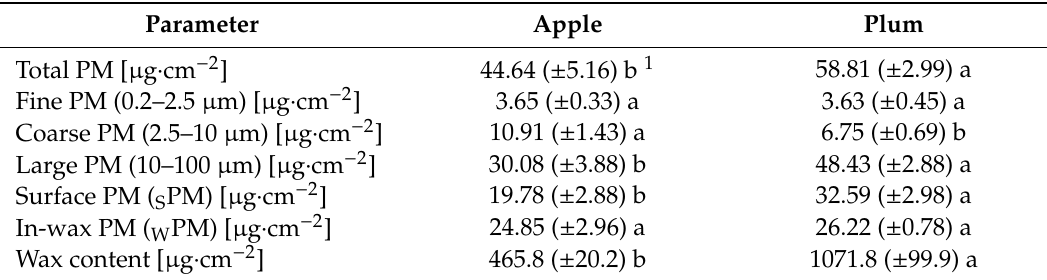
Table 10. E ff ect of fruit species (apples, plums) on accumulation of total PM (0.2–100 µ m), fine PM (0.2–2.5 µ m), coarse PM (2.5–10 µ m), large PM (10–100 µ m), surface PM ( S PM), in-wax PM ( W PM), and wax content. Data are means ± SE, n = 9 (3 replications × 3